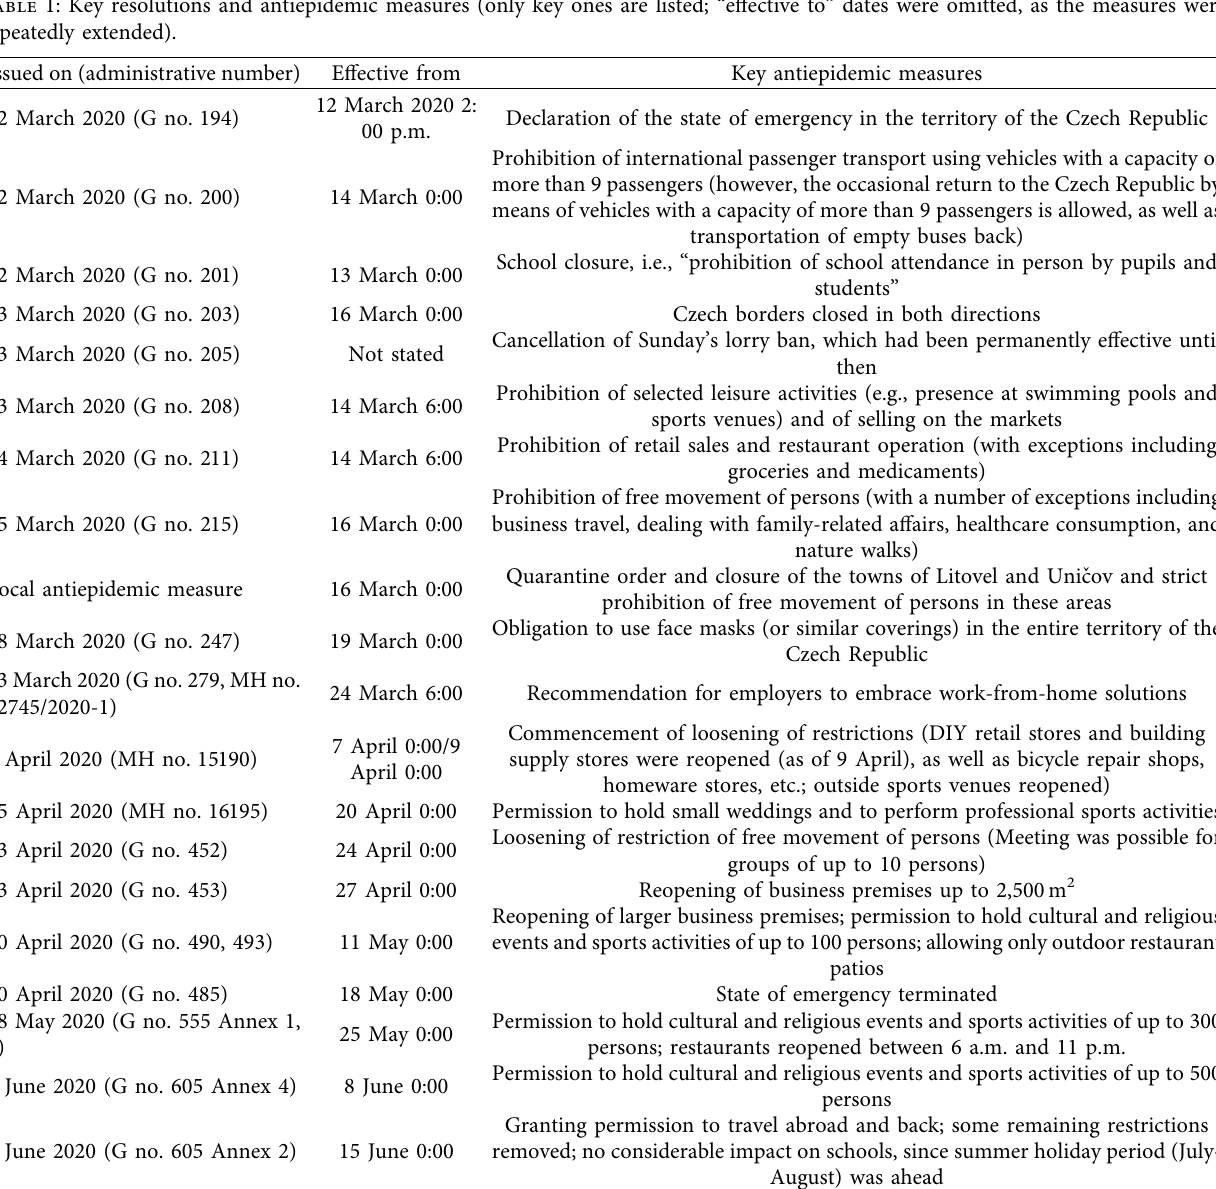
Table 1: Key resolutions and antiepidemic measures (only key ones are listed; “effective to” dates were omitted, as the measures were repeatedly